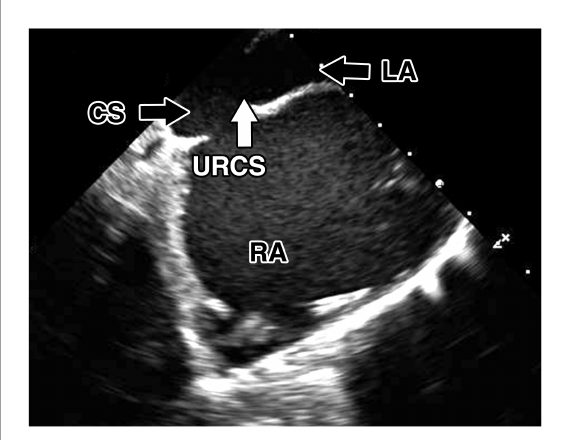
FIGURE2 Preoperative transesophageal echocardiography. Preoperative transesophageal echocardiography images of the unroofed coronary sinus. Direct communication between the coronary sinus and left atrium. CS, coronary sinus; LA, left atrium; RA, right atrium; URCS, unroofed coronary